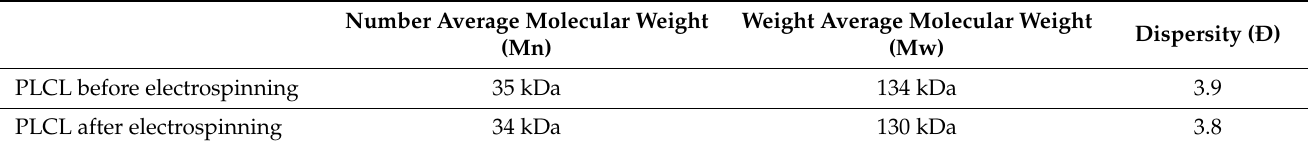
Table 2. Properties of PLCL before and after electrospinning.